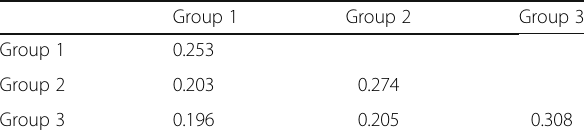
Table 2 Genetic distance estimates calculated using Nei et al. distance matrix within and between Gossypium arboreum groups identified by STRUCTURE analysis